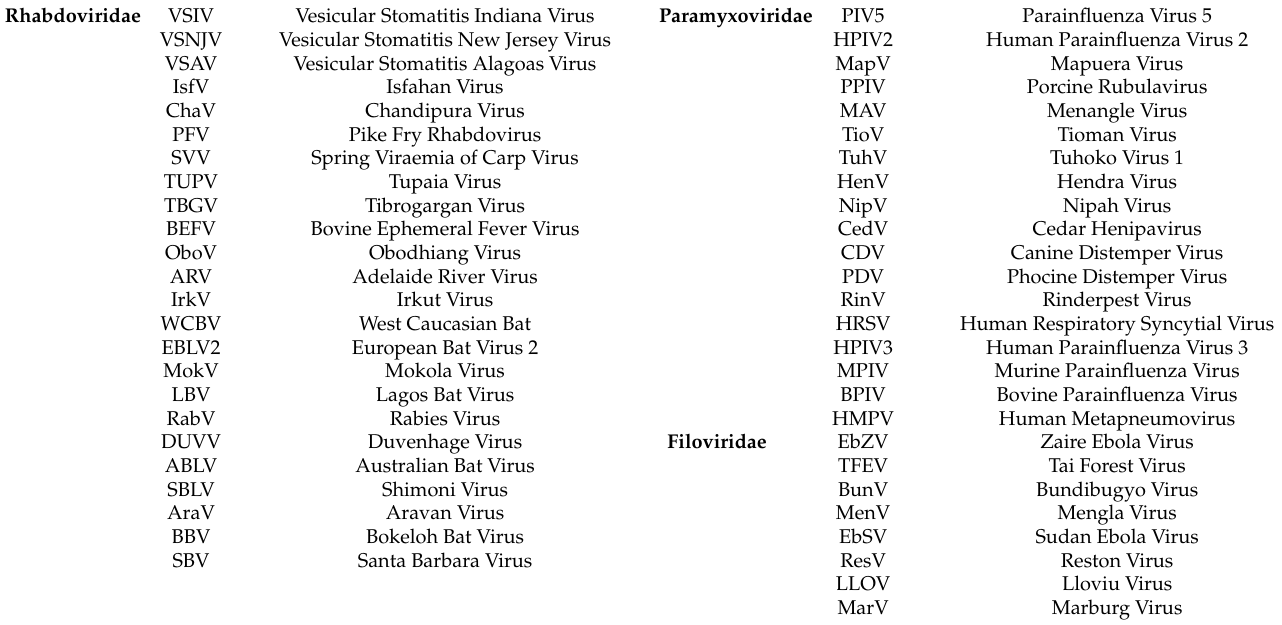
Table A1. Virus abbreviations used in Figure